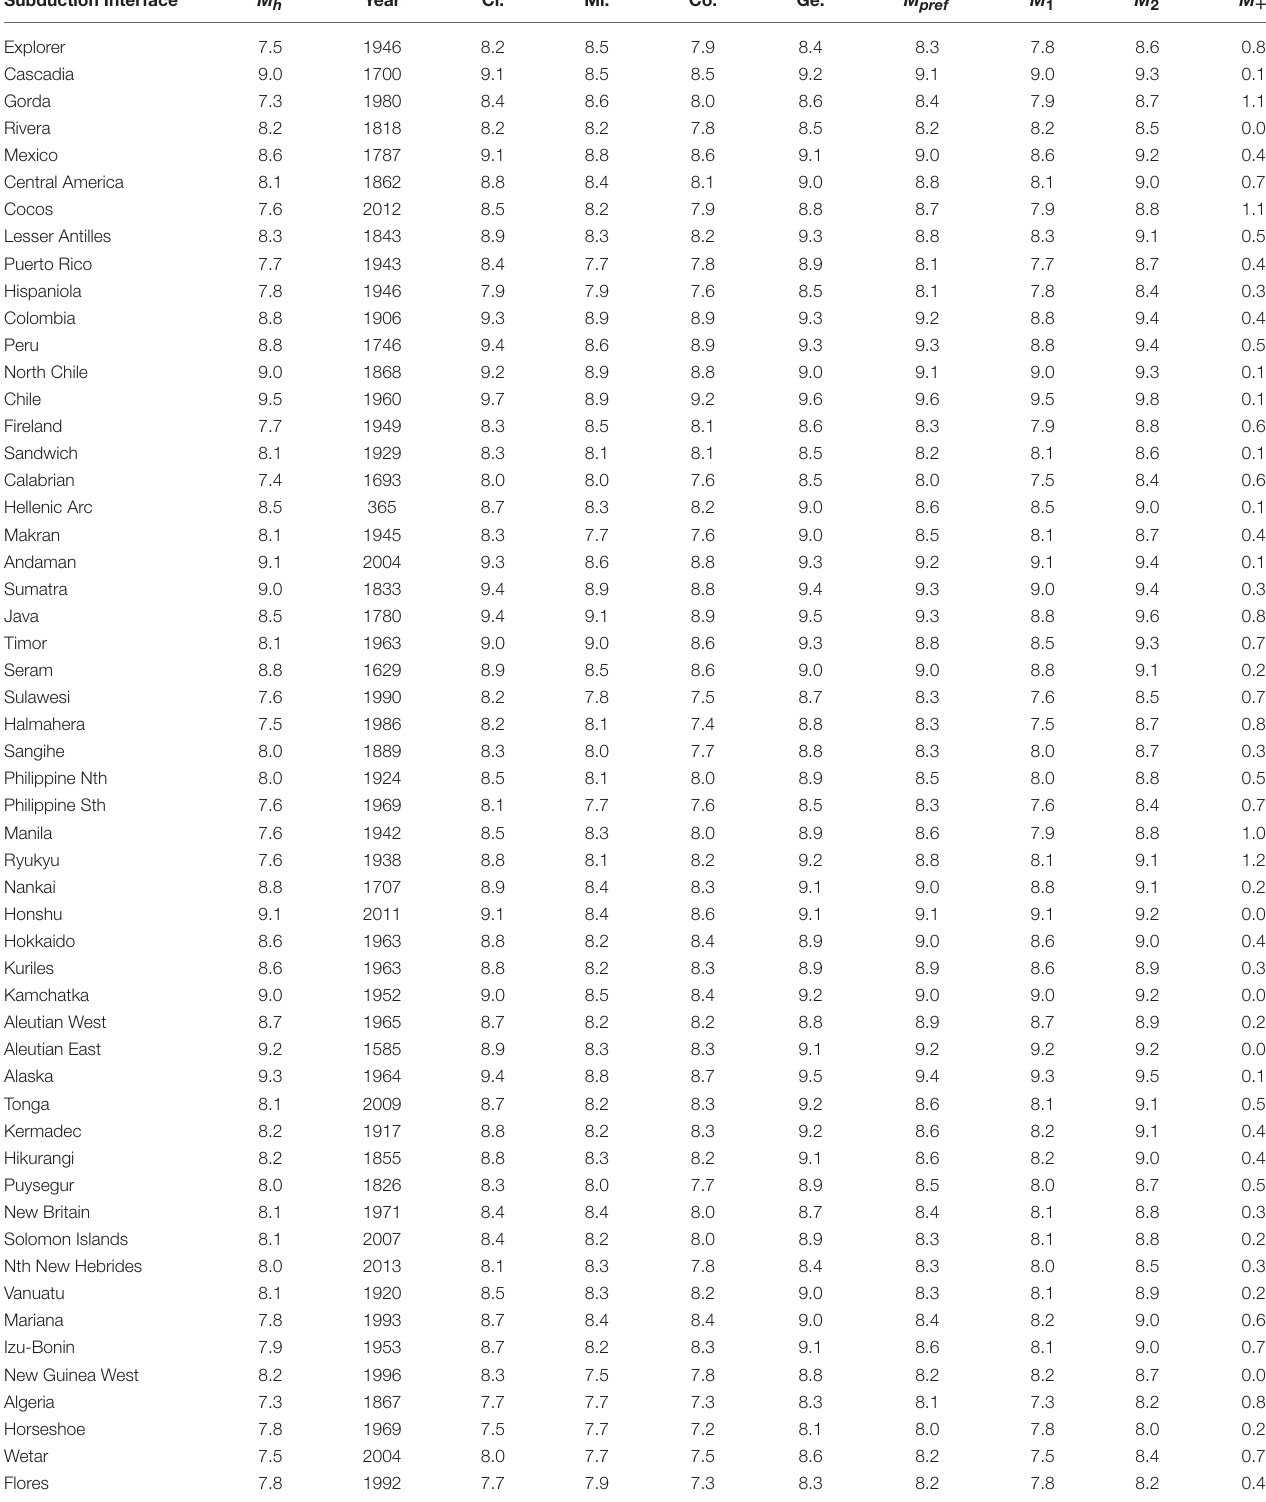
TABLE 4 | Collection of resulting M max estimates of all logic tree components for subduction zones with M pref ≥ 8.0. Subduction